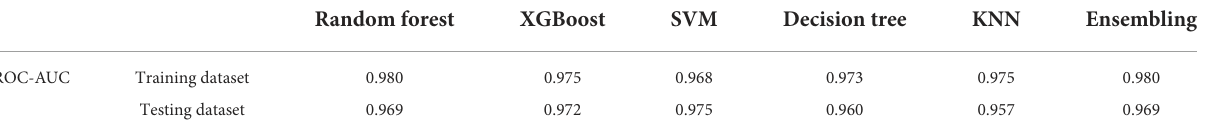
TABLE 3 ROC-AUC score comparison.